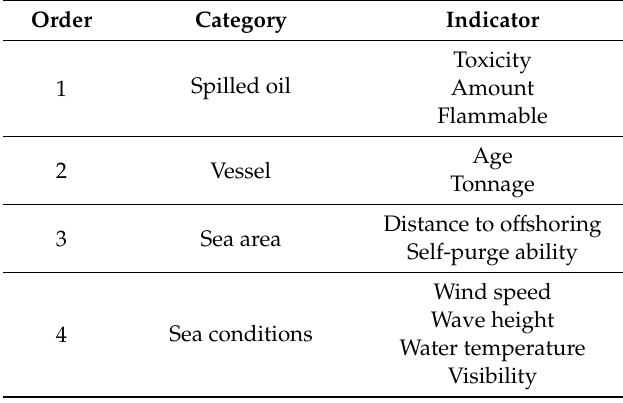
Table 2. Eleven indicators used to measure the severity of marine oil spill